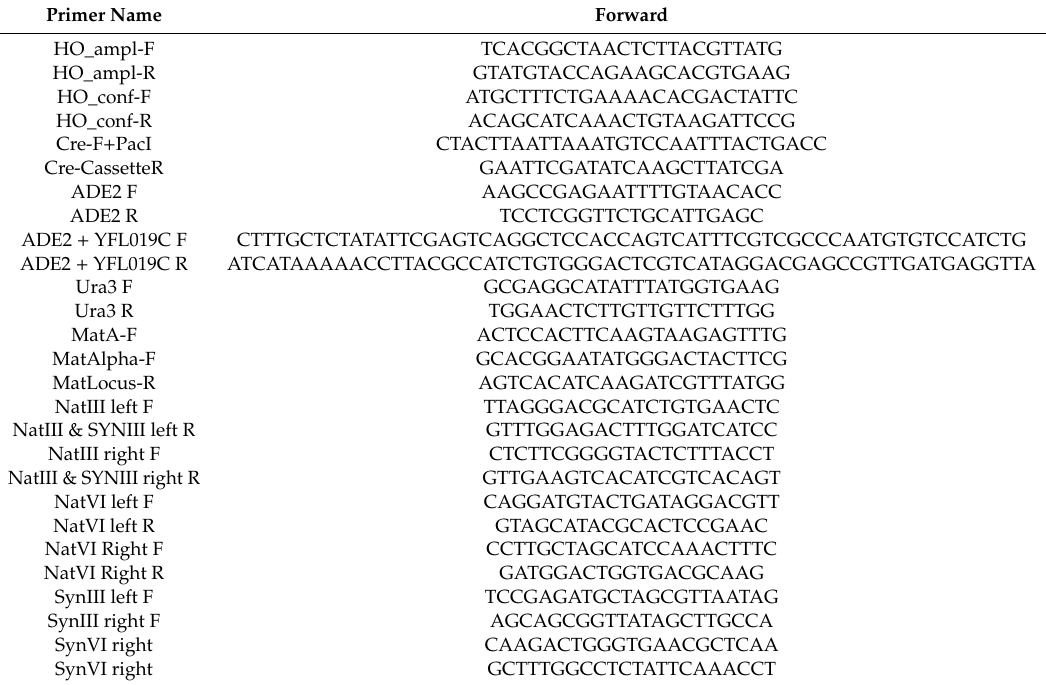
Table A1. Primers used in this